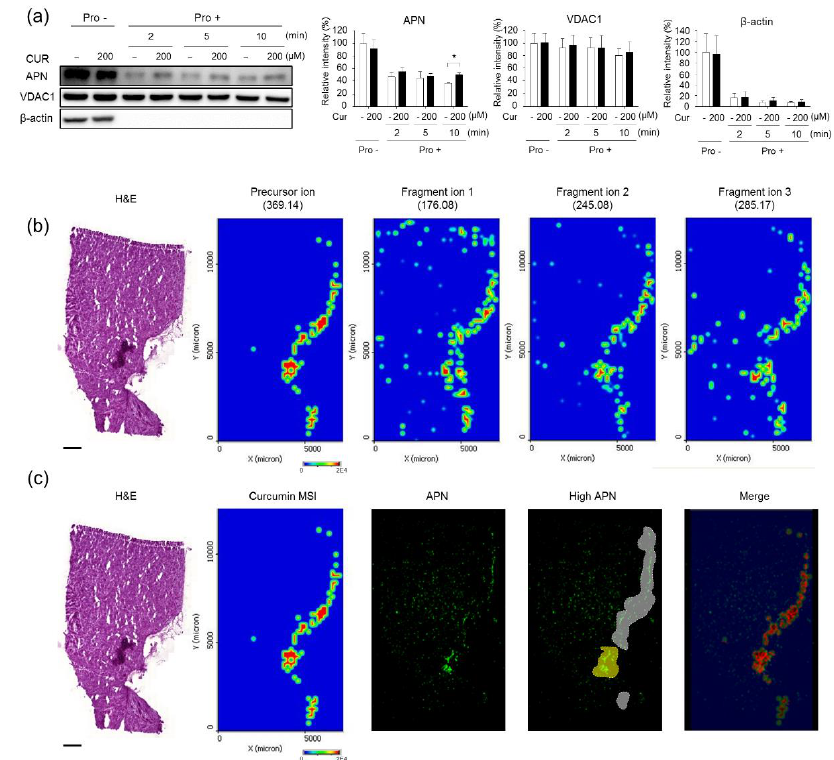
Figure 1. Validation of a systematic combination of drug affinity responsive target stability and mass spectrometry imaging (DARTS-MSI) for curcumin-aminopeptidase N (APN) interaction. ( a ) Analysis of direct binding of curcumin with APN in human umbilical vein endothelial cells (HUVECs) using the DARTS assay and immunoblotting. HUVEC lysates were incubated with curcumin and digested with pronase (0.1 μg/mL) at each incubation time. All images are the representative of three independent experiments. Each value represents the mean ± S.D. from three independent experiments. * p < 0.05 versus control. Cur: curcumin-treated, APN: aminopeptidase N. Pro -:Pronase non-treated; Pro + :Pronase treated; -:Non-treated ( b ) MALDI-MSI images of curcumin (precursor ion, fragment ion 1, fragment ion 2, and fragment ion 3) on curcumin-treated tumor tissue. The results shown are representative of three independent experiments. Scale bar, 1 mm. ( c ) Comparison of curcumin MSI (precursor ion) and immunofluorescence staining of the target protein, APN, in curcumin-treated tumor tissue. The transparent MSI image of curcumin is overlaid on the immunofluorescence staining image for APN and is visualized in the merged region (red). Scale bar, 1